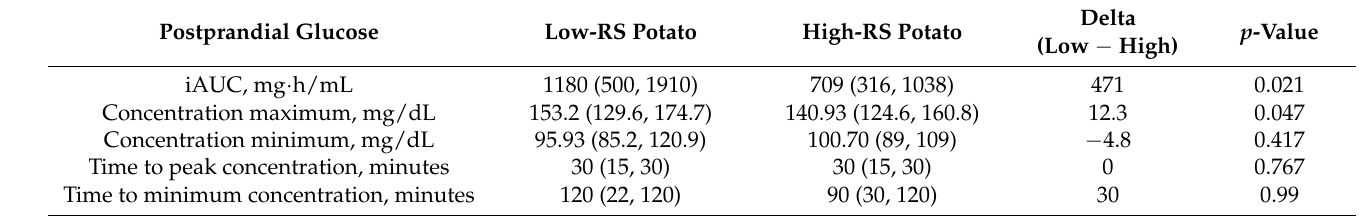
Table 1. Postprandial glucose response of women with overweight ( n = 30) following hot and cold potato consumption.